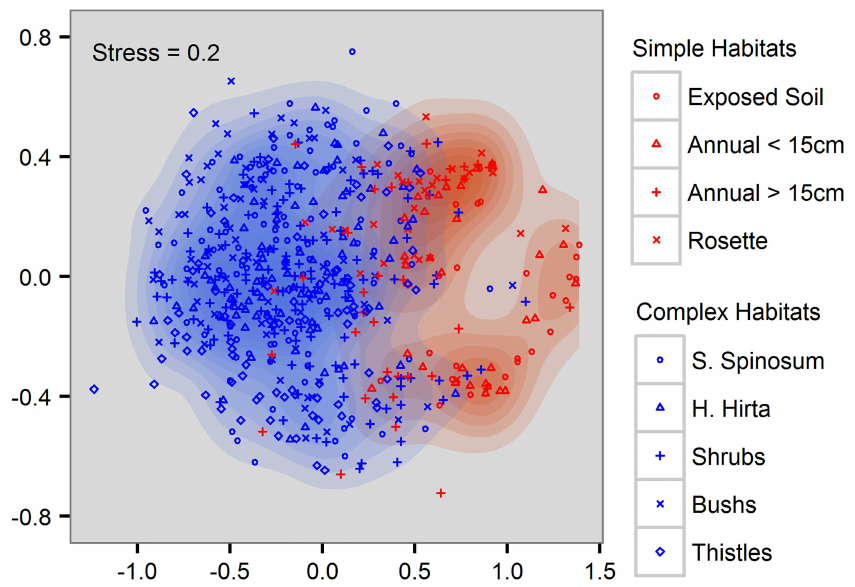
Fig 3. non-metric multidimensional scaling of all samples. Note the clear separationbetweenthe simple habitats and the complex habitats along the first axis. The second axis correspondedmainly to landscape(S1